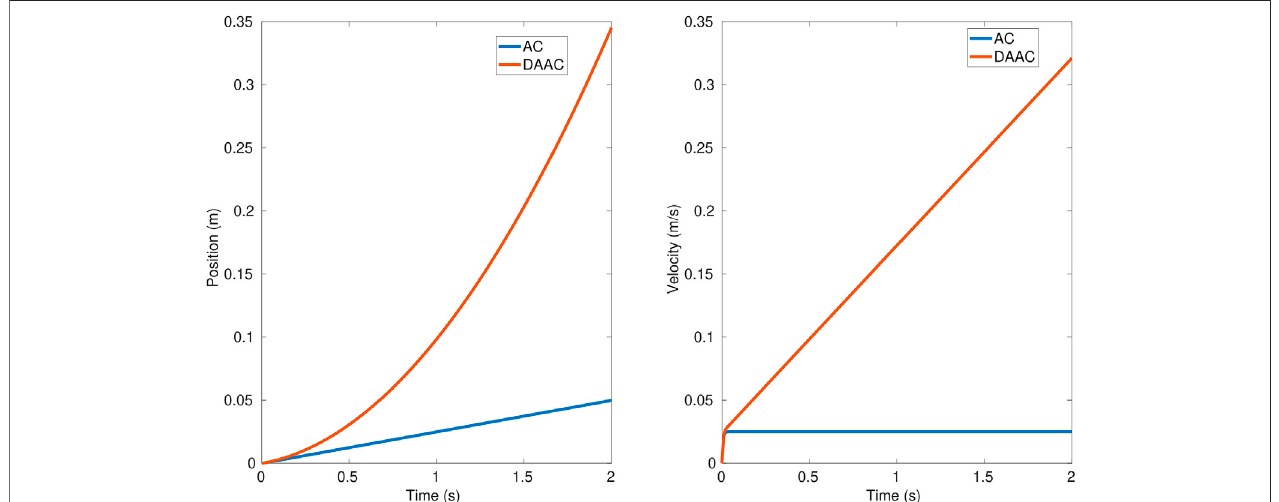
FIGURE 6 | Position and velocity evolution with the AC (blue line) and DAAC (red line), once there is a contact loss and no switching to free motion control.